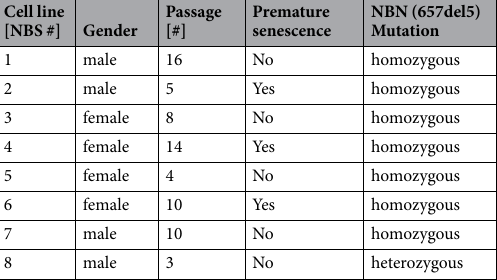
Transcription Regulator